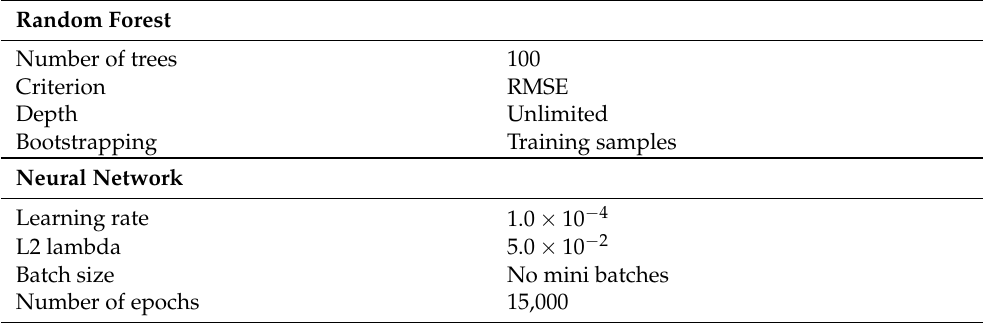
Table A2. Hyperparameters of the random forest and the neural network.